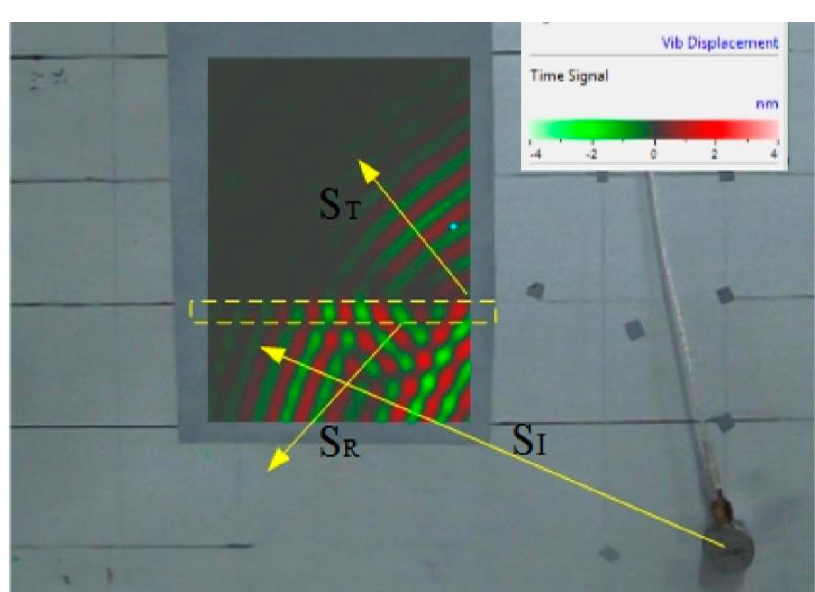
Figure 8. The signal propagate diagram (at 0.15392